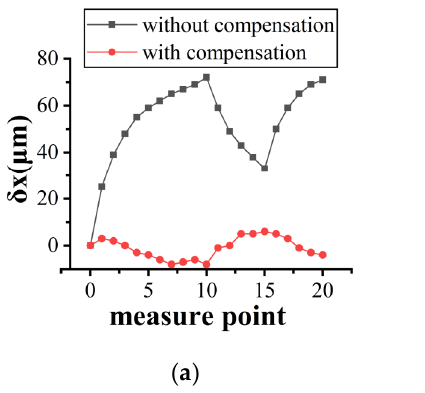
( c ) Figure 15. Machining and measurement of the test piece. ( a ) Clamping. ( b ) Machining. ( c ) Measure- ment.